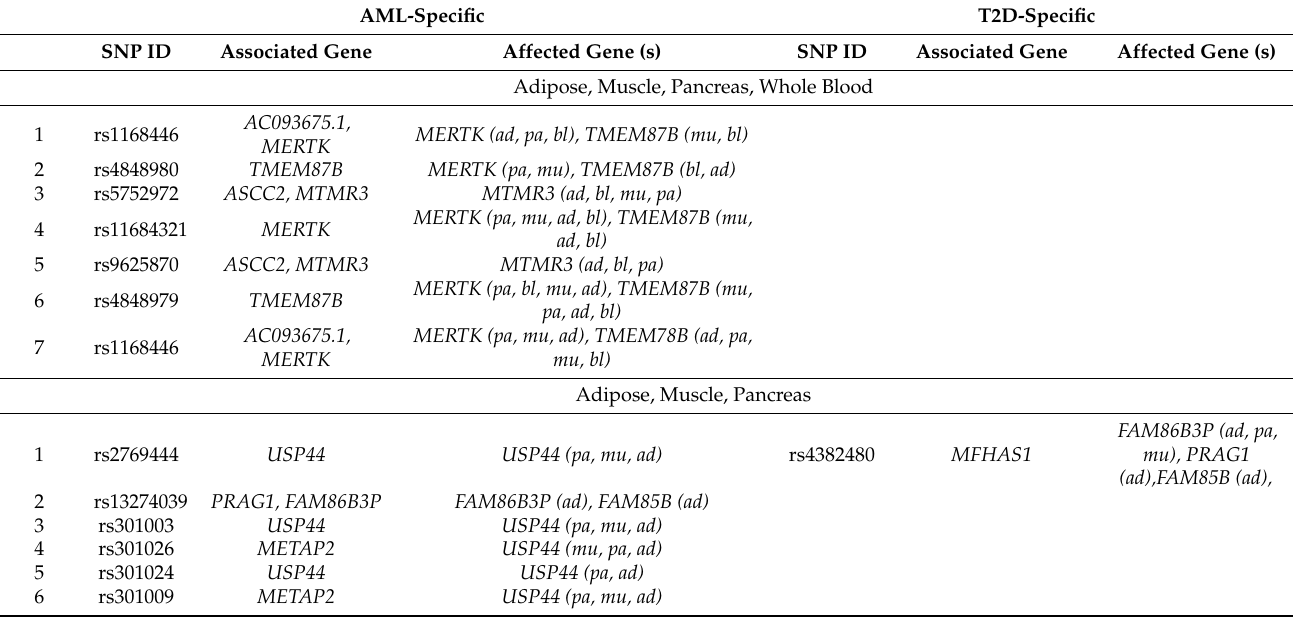
Table 5. AML- or T2D- specific SNPs that act as eQTLs on the 86 common AML/T2D susceptibility genes in a tissue-specific manner, as analyzed via the GTex portal [21] (May